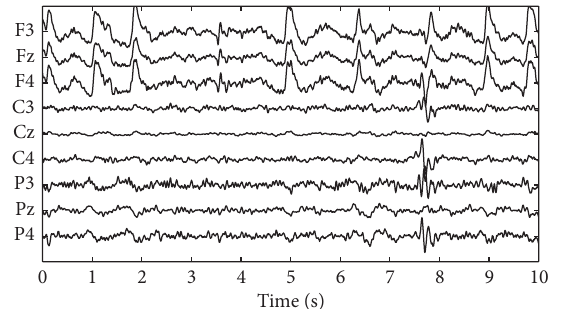
Figure 8: Reconstructed EEG signals after muscle artifact removal.